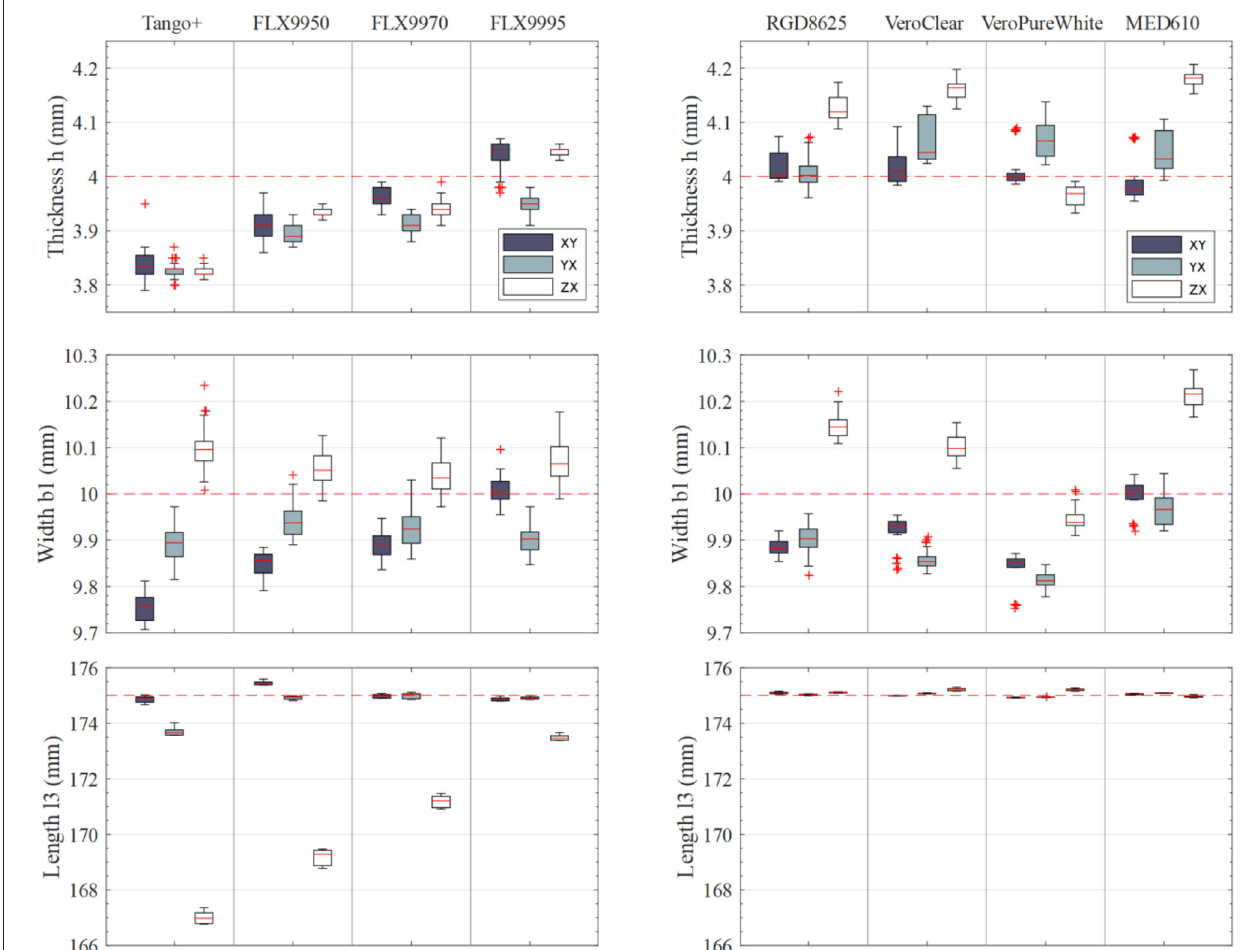
FIGURE 7 | Boxplots of the dimensional data of all tested materials at three different orientation levels ( n = 30 for h and b1, n = 6 for l3). Red dashed lines illustrate the nominal dimensional values. Red bars within the interquartile range delimited by the box itself show the median; outliers are shown as red + signs.